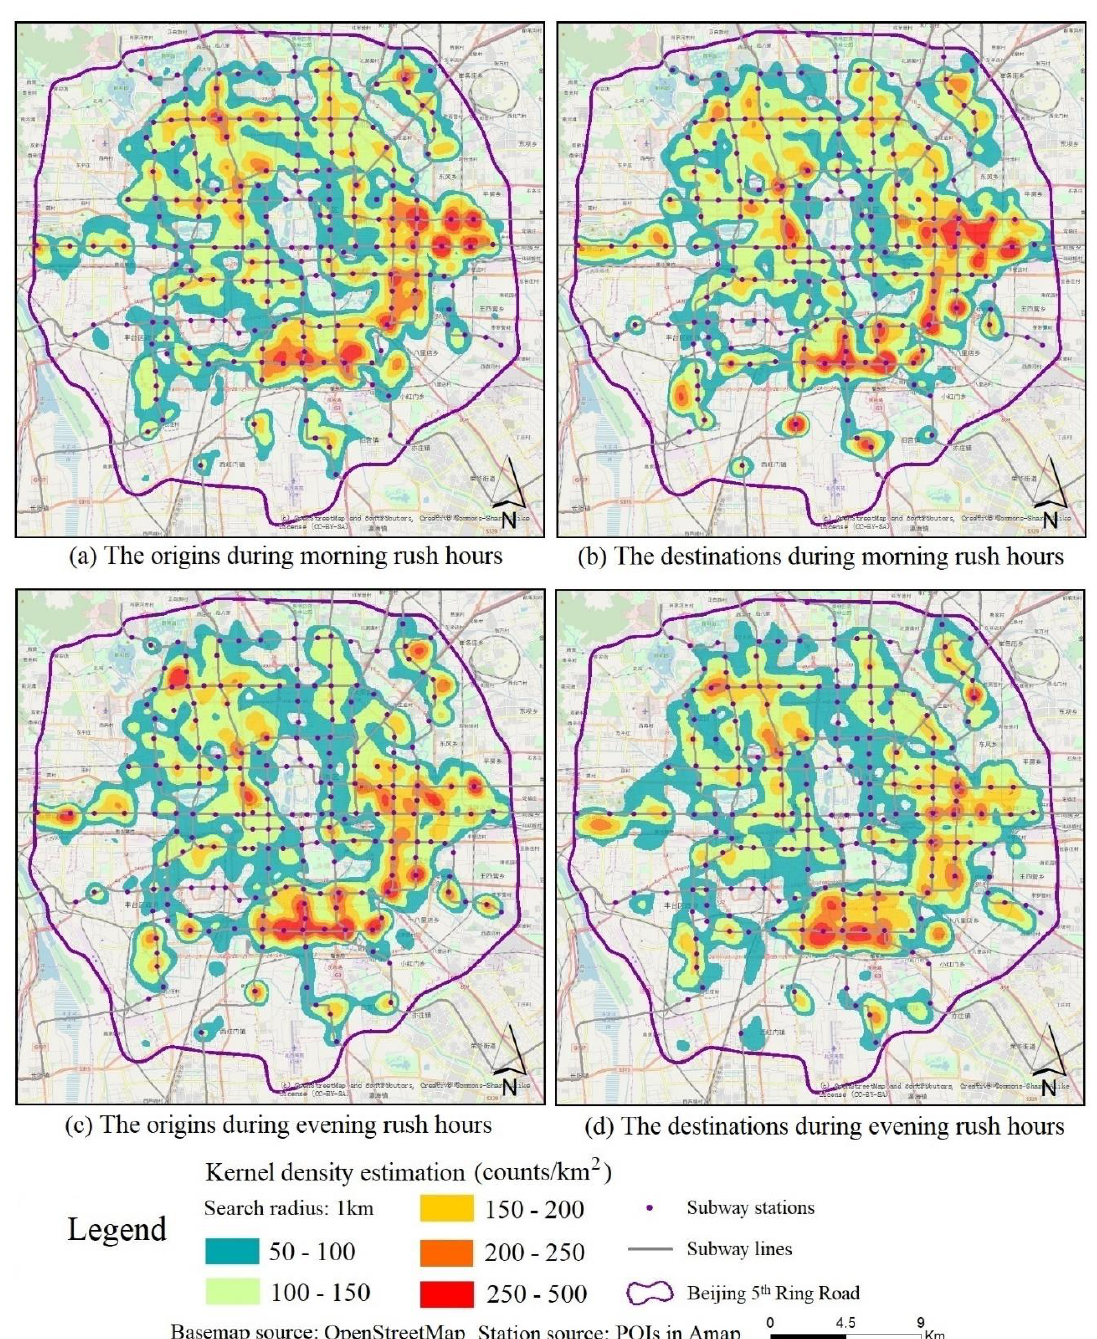
Figure 5. The shared bicycle hotspots on the weekdays.